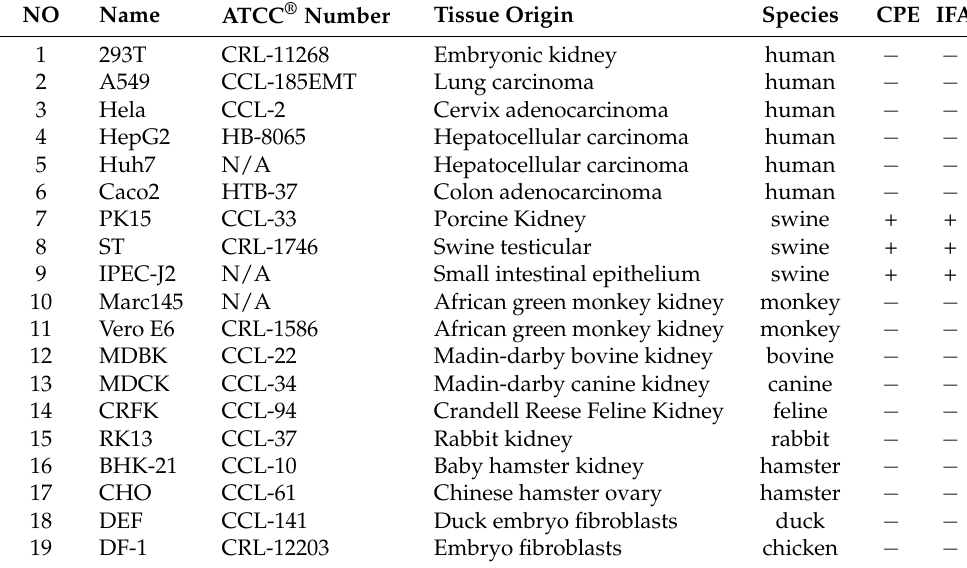
Figure 5. Susceptibility of PSV to cell lines derived from various species. Cell lines of Human (A549, HeLa, Huh-7, HepG2, Coca2 and 293T), Swine (PK15, IPEC-J2, and ST), Monkeys (Marc-145 and Vero), Bovine (MDBK), Canine (MDCK), Feline (CRFK), Rabbit (RK13), Hamster (BHK-21 and CHO), Duck (DEF) and Chicken (DF-1) were infected with PSV at an MOI of 0.01, and fixed at 24 hpi. Cell monolayers were determined by IFA using PSV mAb. Table 2. Summary of cell lines susceptibility to PSV as determined by CPE and